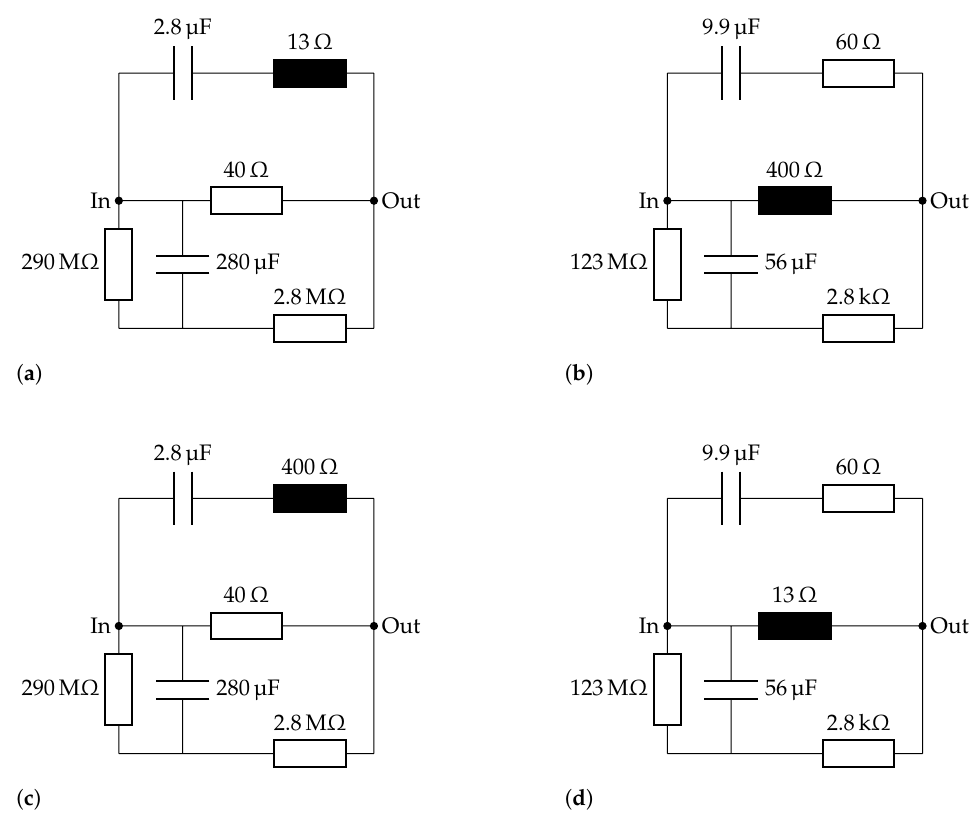
Figure 5. Two circuits before (parents) and after (children) crossover. ( a ) Parent 1; ( b ) Parent 2; ( c ) Child 1; ( d ) Child